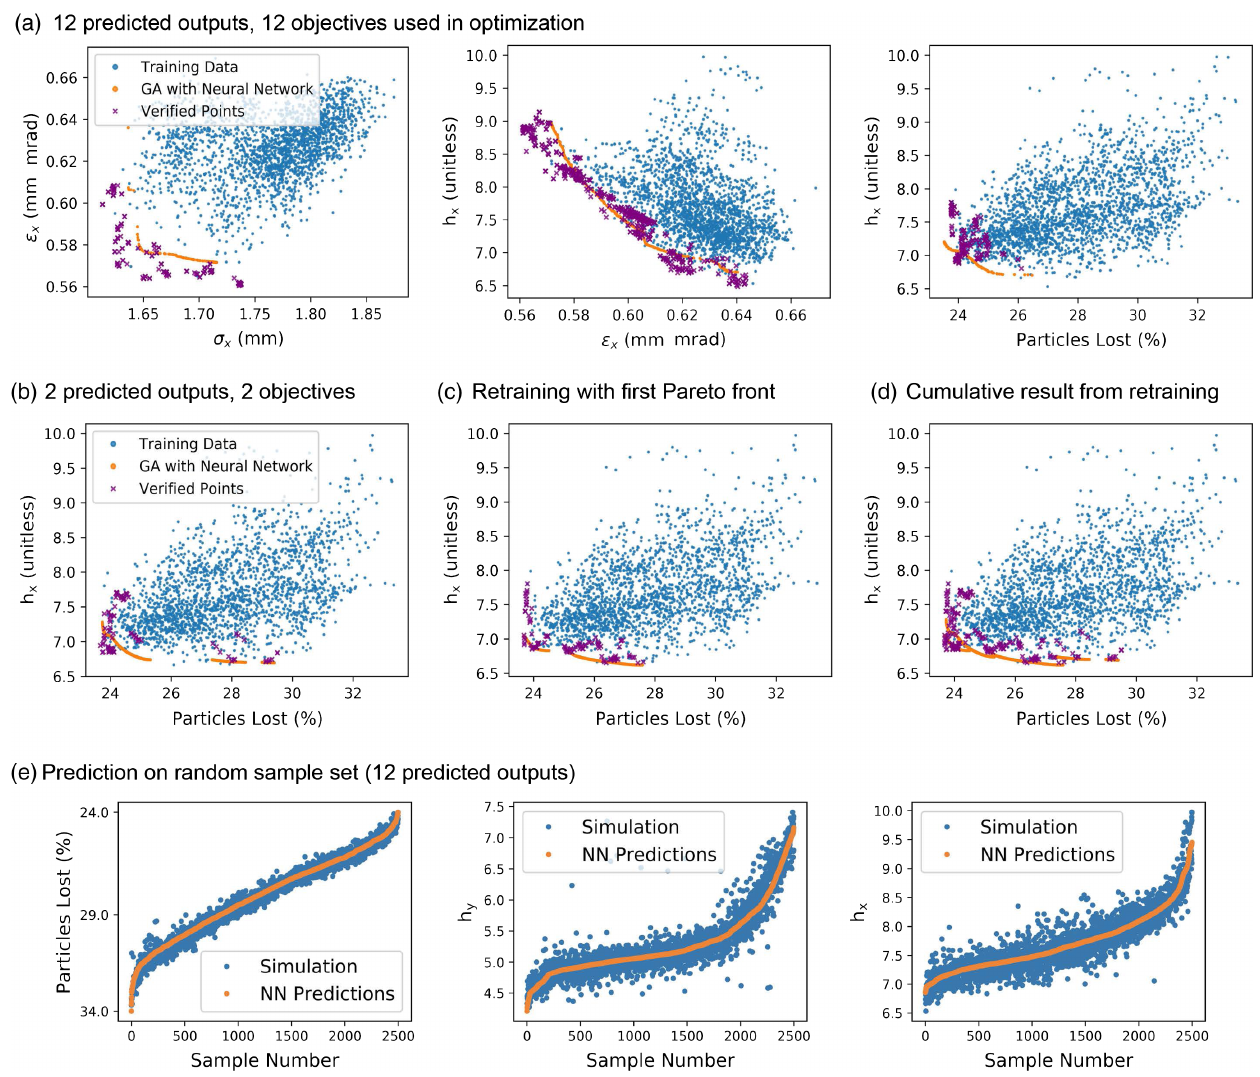
FIG. 13. Example of estimated Pareto fronts from IsoDAR NN model and corresponding verified points from the physics simulation. We first show results from training a model to predict and optimize 12 beam parameter outputs (a). We then show corresponding results from training only on the two most challenging beam parameter outputs, h and P (b). We then include the verified front from the x L previous model in the training set, retrain the model, repeat the optimization, and check the new Pareto points (iterative retraining) (c). Although the fronts do not match as well as they do for the AWA, for this challenging problem it is encouraging that we can predict roughly accurate fronts. Finally, we show the prediction on sorted values of the random